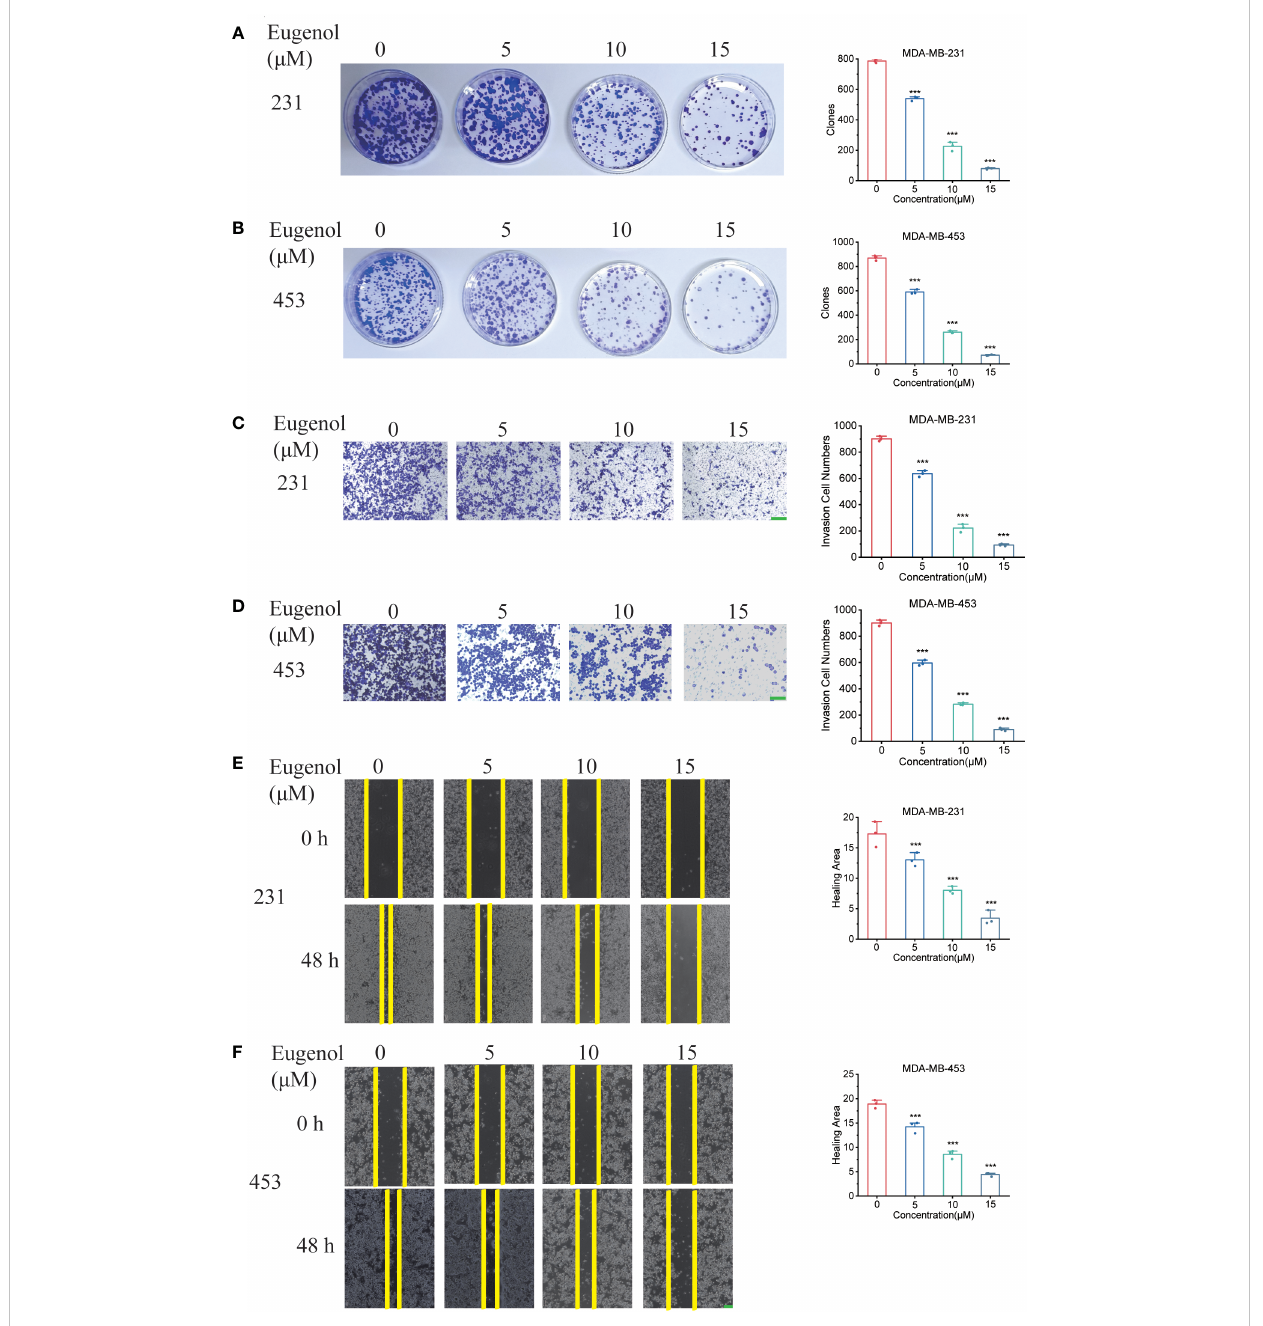
FIGURE 2 Eugenol inhibits TNBC cell metastasis and proliferation. (A, B) Colony formation assay for proliferation ability in MDA-MB-231 and MDA-MB-453 cells after eugenol treatment. (C, D) Detecting the ability of cell metastasis after eugenol treatment by transwell assay in MDA-MB-231 and MDA-MB-453 cells. Scale bar:green, 200 m m. (E, F) Wound healing analysis of migration of MDA-MB-231 and MDA-MB-453 cells treated with eugenol for 48 h. Scale bar:green, 200 m m. The data are presented as the means ± SD. Student ’ s t-test, n=3. ***P <